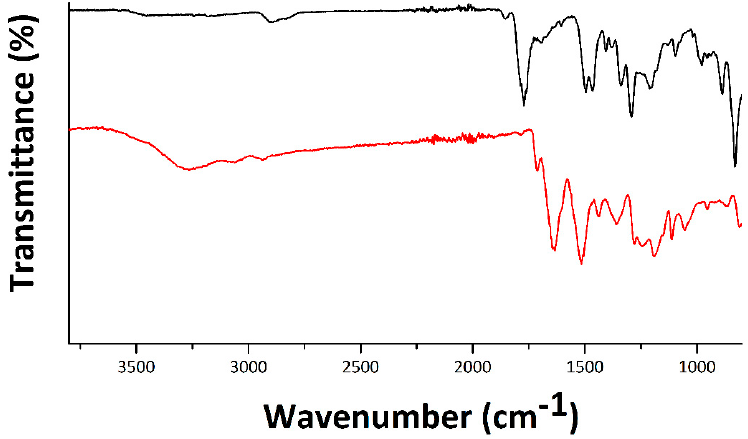
Figure 2. Fourier transform-Infrared (FT-IR) spectra of PSI (black) and Poly(AspAm(DOPA/EA)) (red).